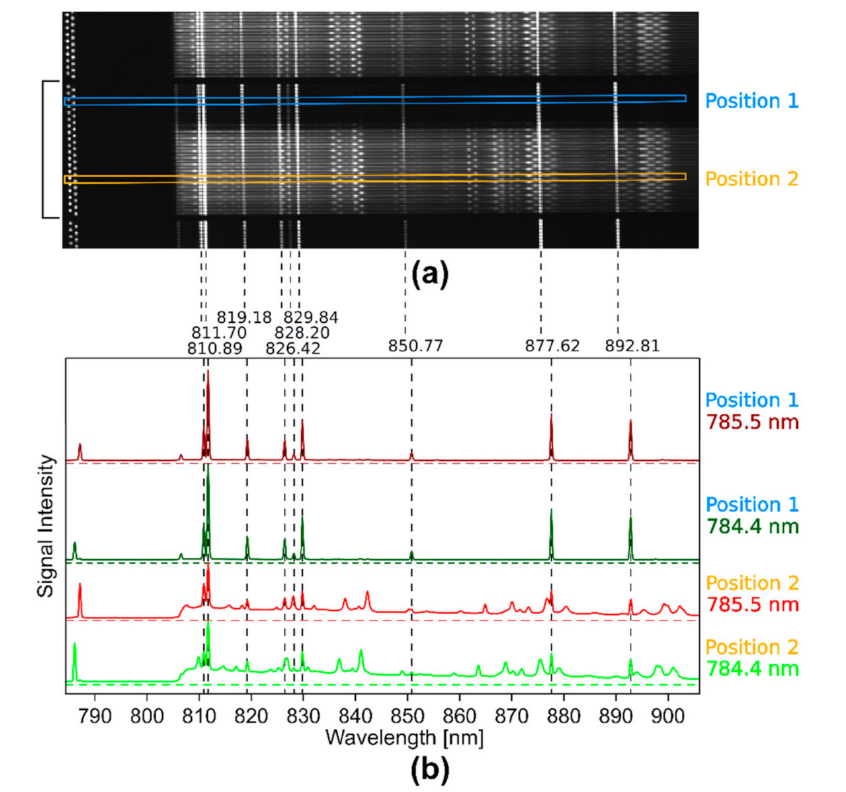
Figure 4. Illustration of the raw, wide field Raman data measured with two di ff erent excitation wavelengths ( λ 1 = 784.4 nm, λ 2 = 785.5 nm) and the nod and shu ffl e technique: ( a ) zoomed view on a part of the CCD chip after acquisition for a closer look on the signal traces. Twenty spectra of each wavelength are always arranged in a block of traces (black square bracket), corresponding to one row of pixels in the Raman images. The upper blue box marks two intensity traces (Position 1) that correspond to a spaxel in the Raman image without a sample. The lower orange box marks two intensity traces (Position 2) that correspond to a spaxel on the Raman image with a paracetamol pill; ( b ) signal intensities of the two signal traces (in dark red and dark green) marked by the upper blue box in the CCD image showing only the room light spectra. In red ( λ 1 ) and green ( λ 2 ), the signal intensities of the two signal traces marked by the lower orange box in the CCD image are shown, which correspond to the paracetamol Raman spectra superposed by room light spectra. The dotted, vertical black lines indicate the position of the fluorescent lamp bands and above their spectral position in